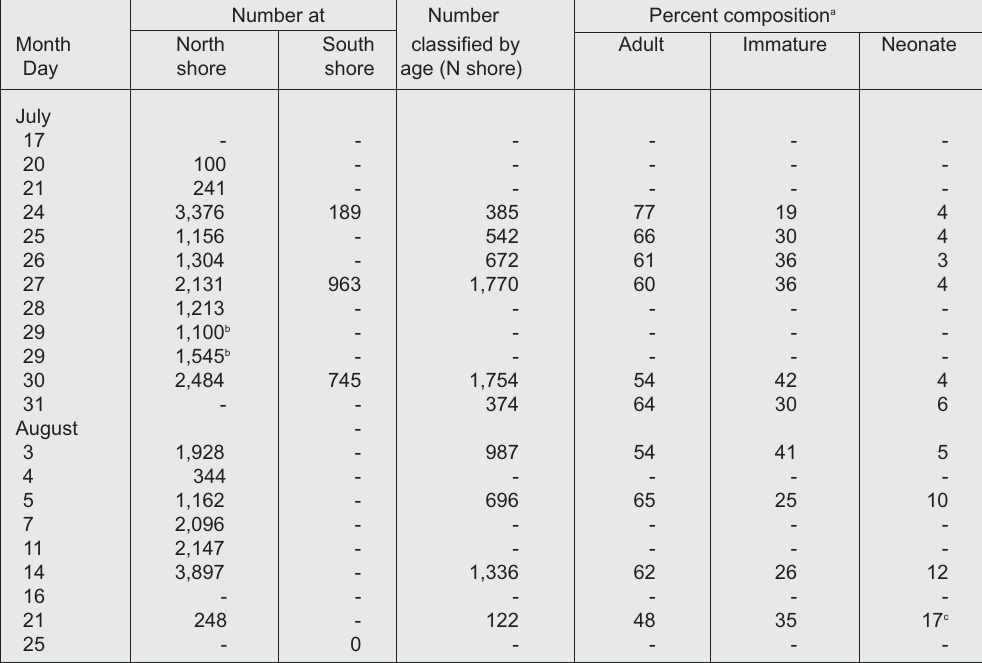
Table 5 . Numbers and age composition of belugas in Creswell Bay, Somerset Island, July - August